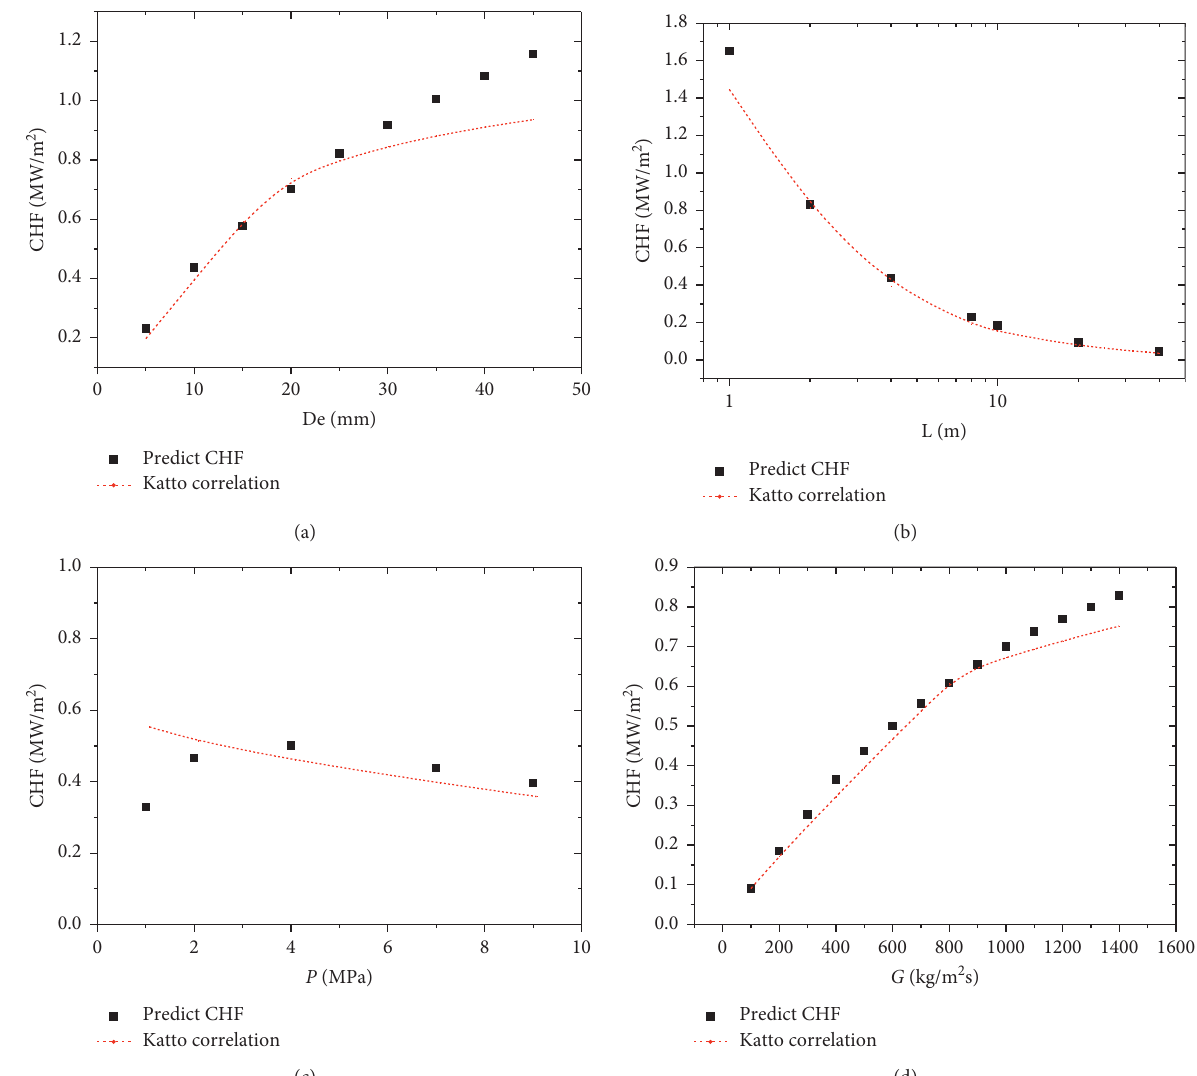
Figure 9: Comparisons between predicted CHF and Katto correlation. (a) With respect to equivalent diameter. (b) With respect to channel length. (c) With respect to system pressure. (d) With respect to mass flux.